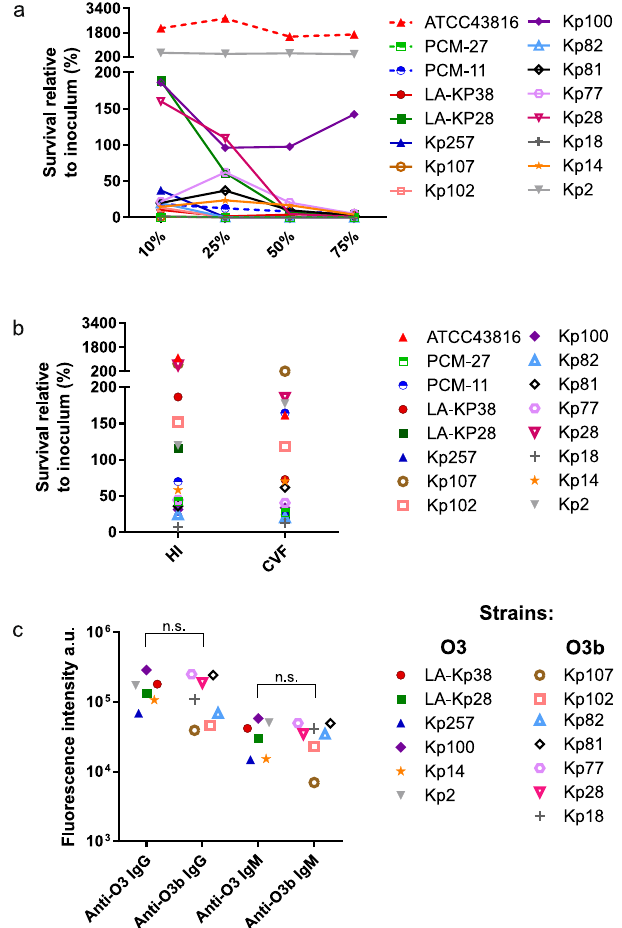
Figure 5. Serum survival of K. pneumoniae strains. Strains were incubated in different concentrations of human serum ( a ) or 75% serum complement-inactivated by heat (HI) or cobra venom factor (CVF) treatment ( b ) for 3 h at 37 °C. The recovered bacterial count was expressed as percentage of the initial inoculum. ATCC43816 (O1:K2) and PCM-27 (O2:K27) strains were used as comparators.Graphs show combined results of 2 and 3 experiments for the active and heat inactivated serum experiments, respectively. The same O3 isolates were stained with 10% human serum pool and IgG and IgM antibodies binding to live bacteria were detected with a labelled anti-human IgG or IgM by flow cytometry ( c ). The median fluorescent intensity is shown as arbitrary units. The difference between the staining intensity for O3 and O3b strains was not significant using the Mann Whitney test (p > 0.05; n.s.). O-serotype and capsule type of the strains are indicated in Table